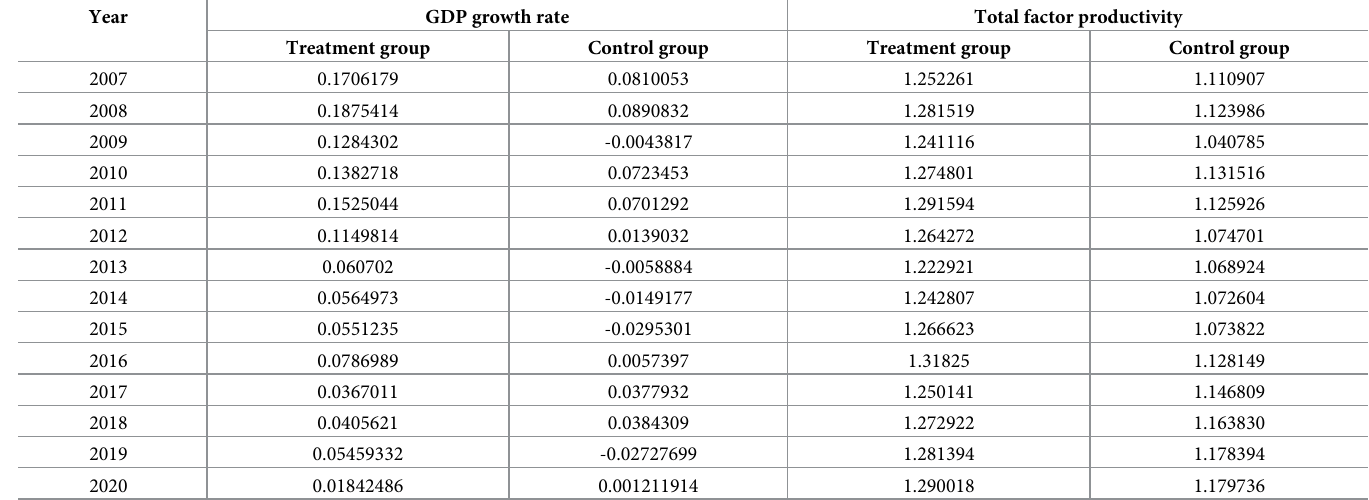
Table 3. Average values of explained variables in each year.